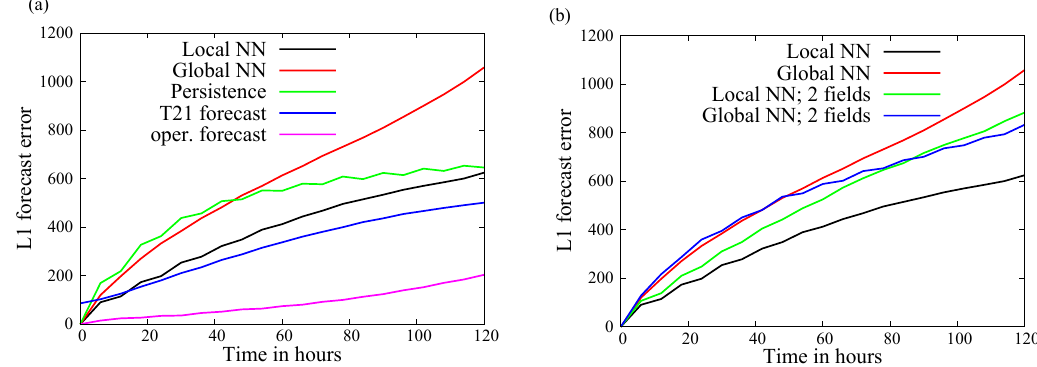
Figure 3. (a) Globally integrated absolute forecast error for the best local network (9 × 9 stencil), the global network, a persistence forecast, an IFS forecast at TL21 resolution and the operational weather forecast of ECMWF. The persistence forecast shows a 12-hourly fluctuation since Z500 has a weak 12-hourly cycle in the tropics due to atmospheric tides. (b) The same globally integrated absolute forecast error for the best local and global network as in (a) plus the best results for local and global networks that use 2mT as additional prognostic